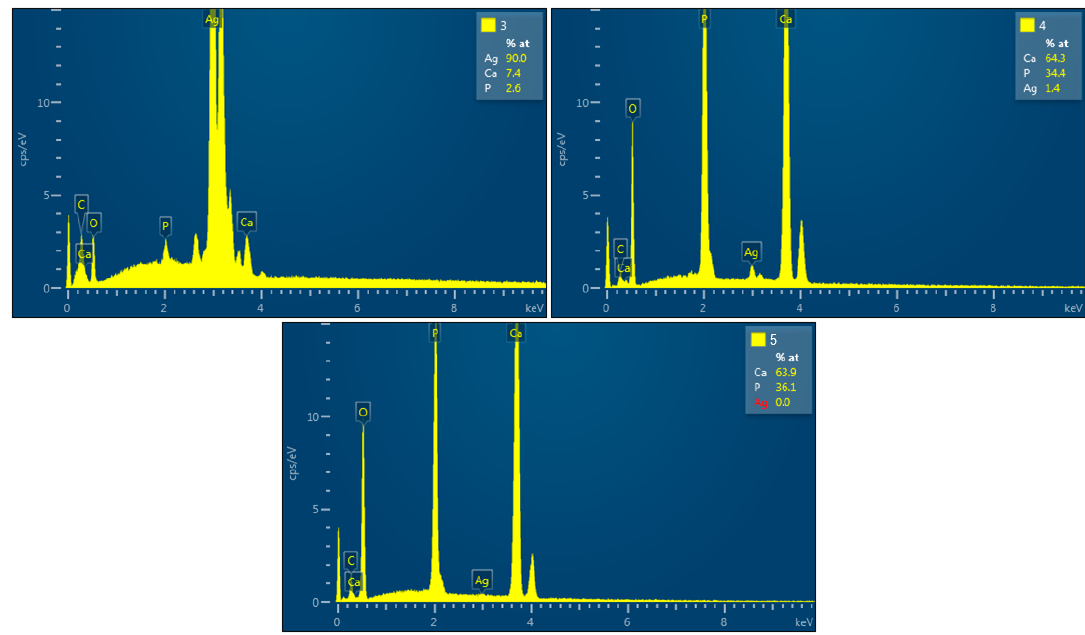
Figure 7. Selected local EDS analyses (presented in Table 2) from zones ‘3’ and ‘4’ of the 25Ag-400 sample and from zone ‘5’ of the 25Ag-700 sample (shown in Figure 6).